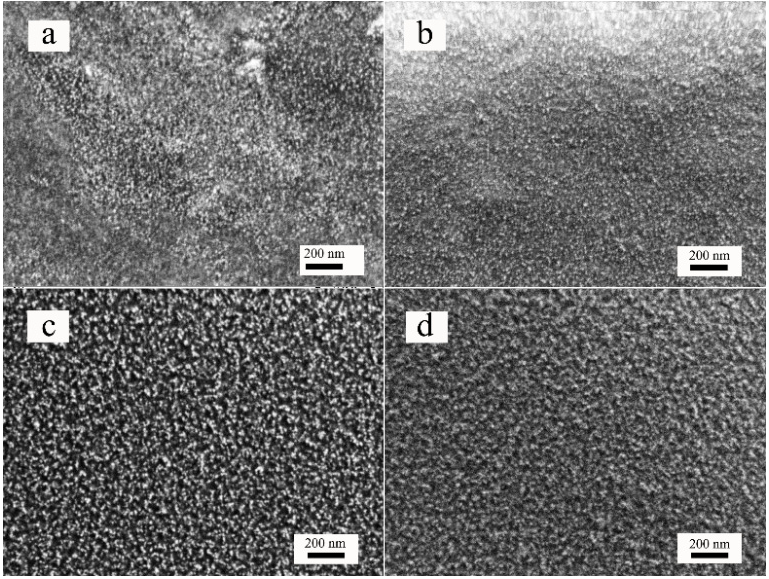
Figure 4. SEM images of Fe 3 O 4 nanoparticles contained within ACX-MNP-gels. ( a ) C = 2.5 wt %; ( b ) C = 5.0 wt %; ( c ) C = 7.5 wt %; ( d ) C = 10.0 wt %; Scale bar: 200 nm.